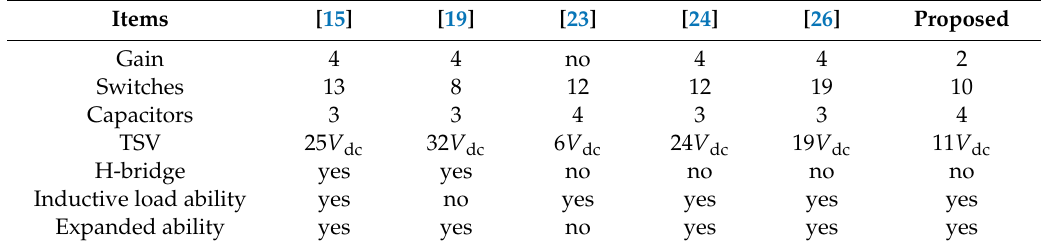
Table 5. Comparison with di ff erent switched capacitor multilevel inverters